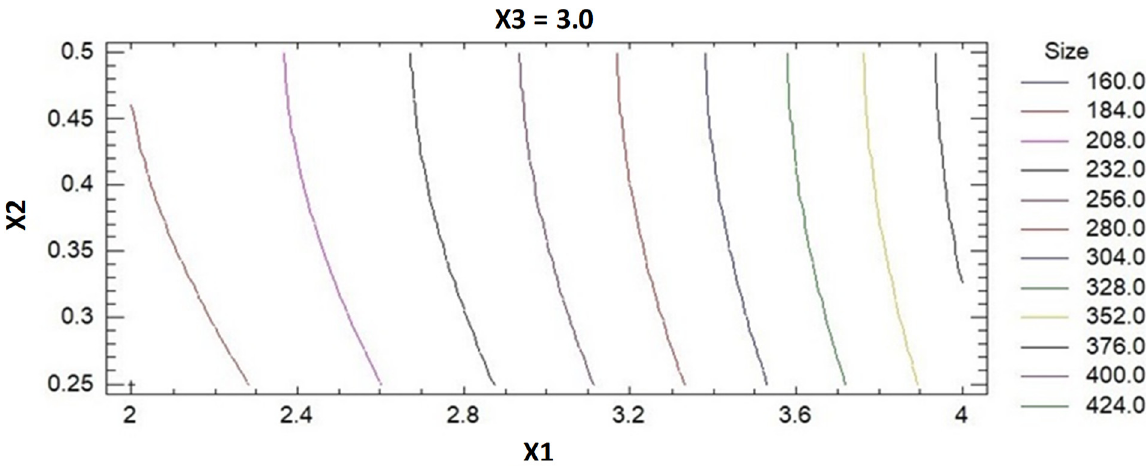
Figure 2. Contours of an estimated response surface for the particle size.